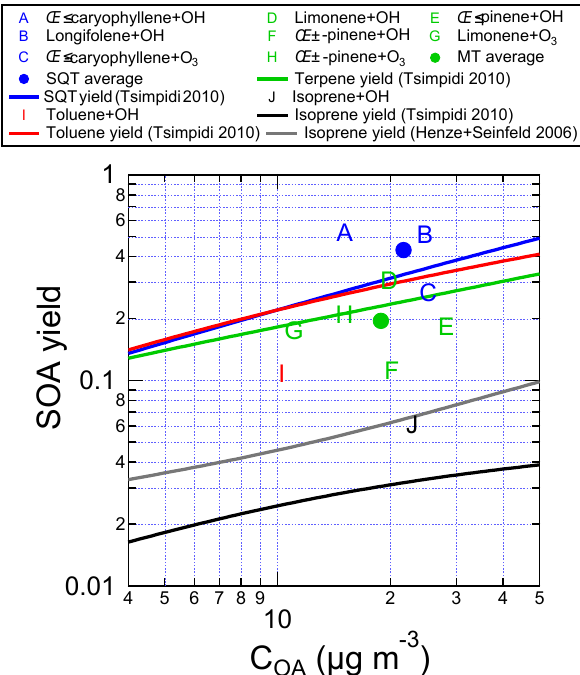
Figure 7. SOA yields measured for individual VOCs in the OFR by standard addition into ambient air, as a function of OA concentra- tion. Typical SOA yield parameterizations (derived from a chemical transport model, which was informed using environmental chamber experiments; Lane et al., 2008a, b; Tsimpidi et al., 2010) are also shown. The VOCs were injected into ambient air at the entrance to the OFR, and aged between 0 and 5 eq. days. Data are corrected for LVOC